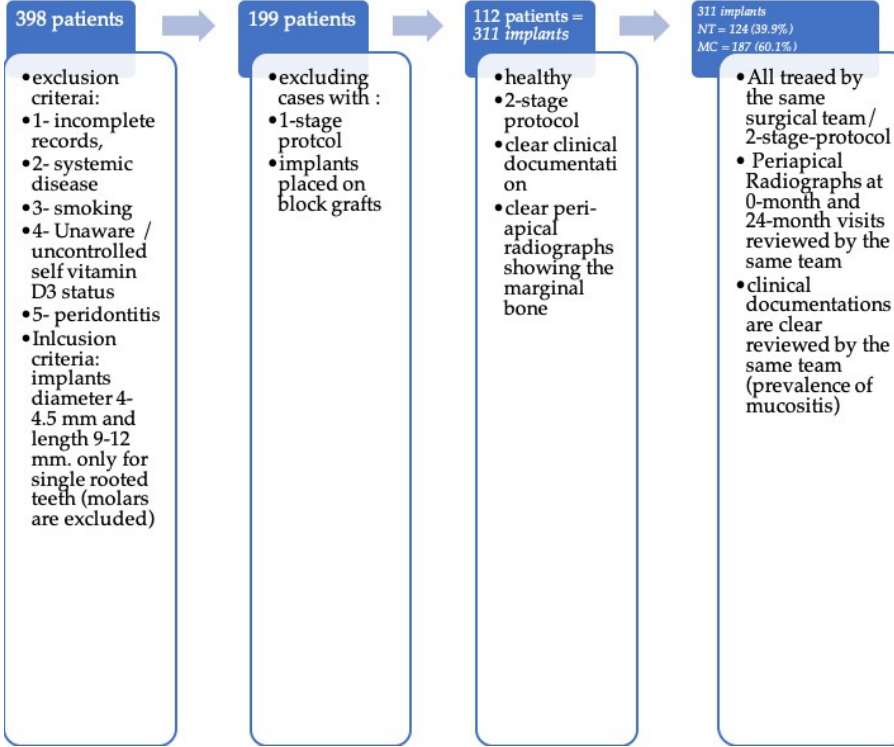
Figure 1. A flow chart presenting the case inclusion/exclusion strategy.